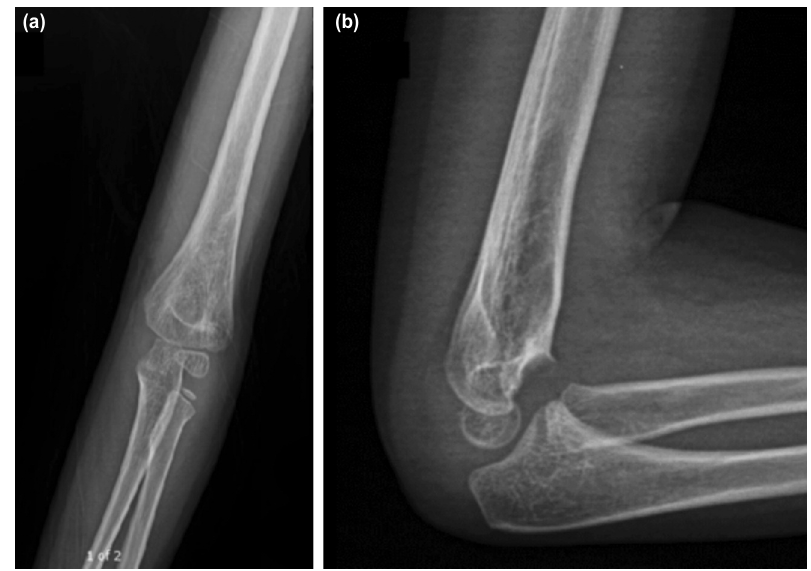
Final follow-up radiographs at 10 months. (a) Anteroposterior and (b) lateral of the left elbow demonstrating complete fracture